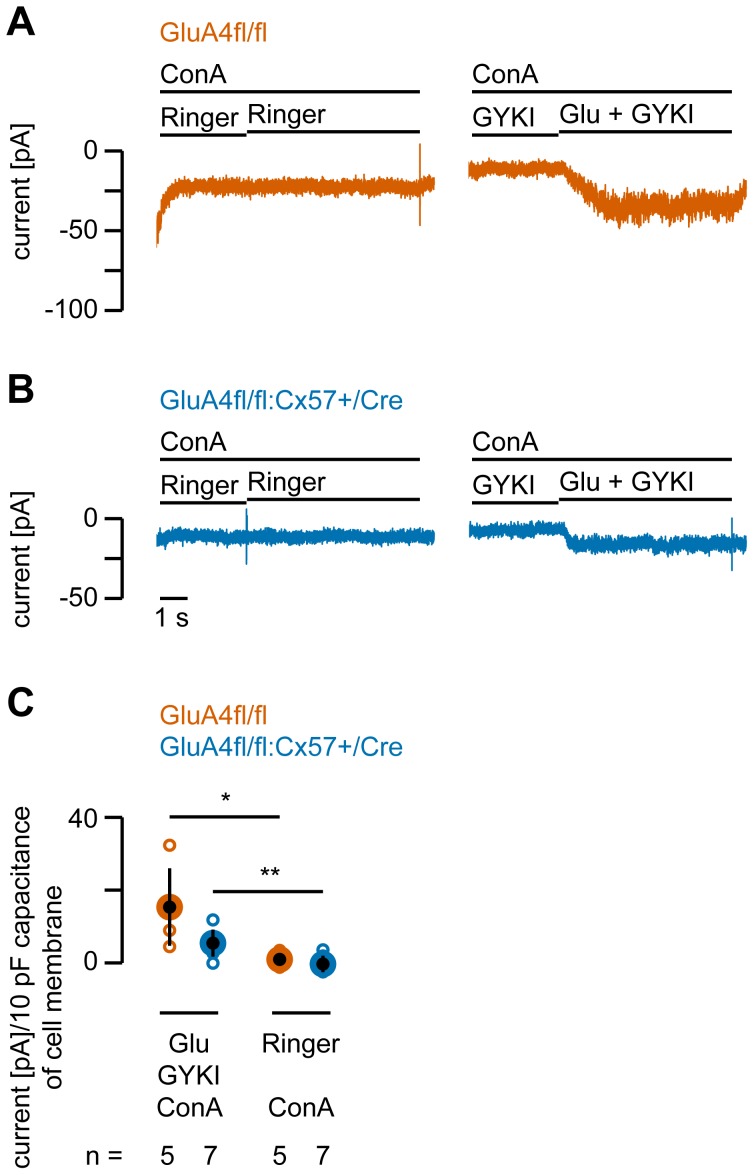
Concanavalin A makes a small contribution of kainate receptors to glutamate responses visible.
A, B, Representative current traces recorded from GluA4-expressing (A) and GluA4-deficient horizontal cell somata (B) upon application of the glutamate and GYKI52466 while concanavalin A (ConA, 1 mg/ml), known to potentiate kainate receptor-mediated currents, was continuously present in Ringer’s solution. In both genotypes, glutamate induced a discernible current when AMPA receptors were blocked, suggesting a small contribution of kainate receptors to the overall glutamate response. C, Quantification of glutamate-induced currents in the presence of ConA. In both genotypes, responses to glutamate in the presence of GYKI52466 and ConA were significantly higher than to Ringer’s application. Current amplitudes in C are normalized to 10 pF capacitance of cell membrane to account for differences in cell size. Small circles represent values for individual cells; large, black filled circles represent the means; error bars show SD. n specifies the number of measured cells. *, p < 0.05; **, p < 0.01.